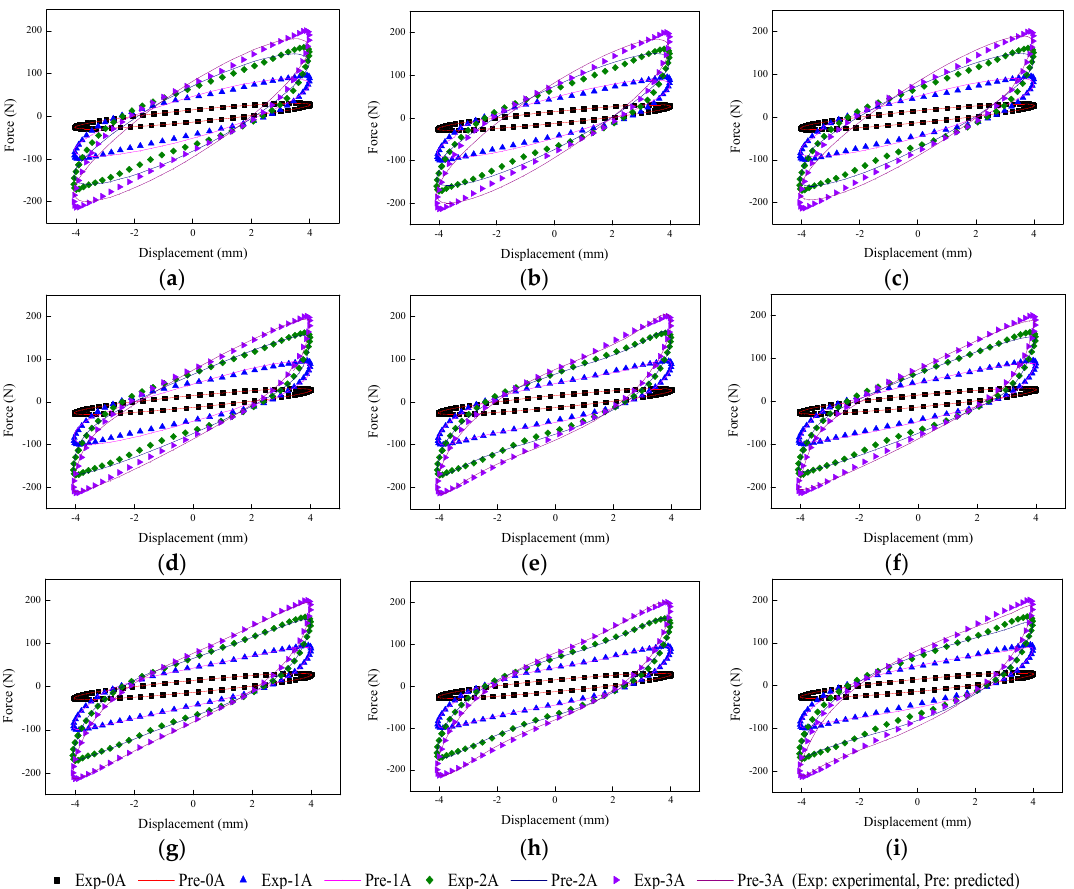
Figure 22. Comparisons of force–displacement responses between experimental results and model predictions when the loading amplitude is 4 mm. ( a ) Kelvin–Voigt model, ( b ) four-parameter viscoelastic model, ( c ) rheological model, ( d ) BW model, ( e ) improved BW model, ( f ) Dahl model, ( g ) improved LuGre friction model, ( h ) strain stiffening model, and ( i ) hyperbolic hysteresis model.